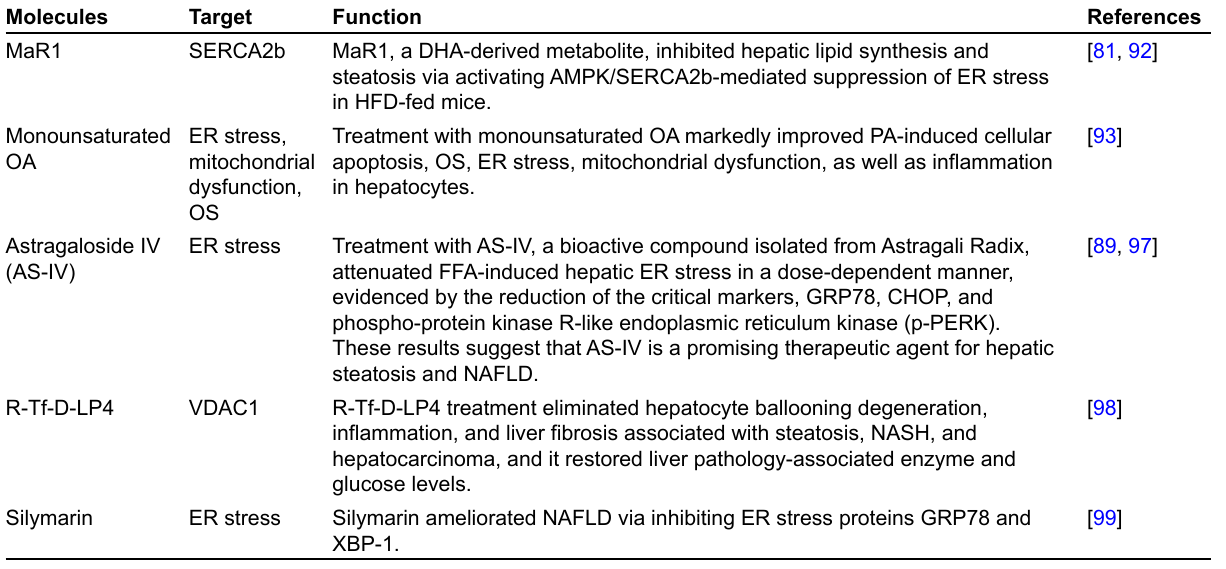
Table 1. Treatment options for NAFLD ( continued )